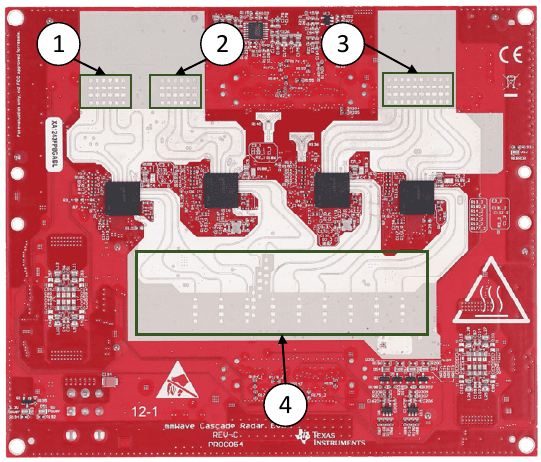
Figure 9. The PCB antenna arrays of MMWCAS-RF-EVM radar. 1, 2, 3 are the receiving antennas and 4 is the transmitting antennas.